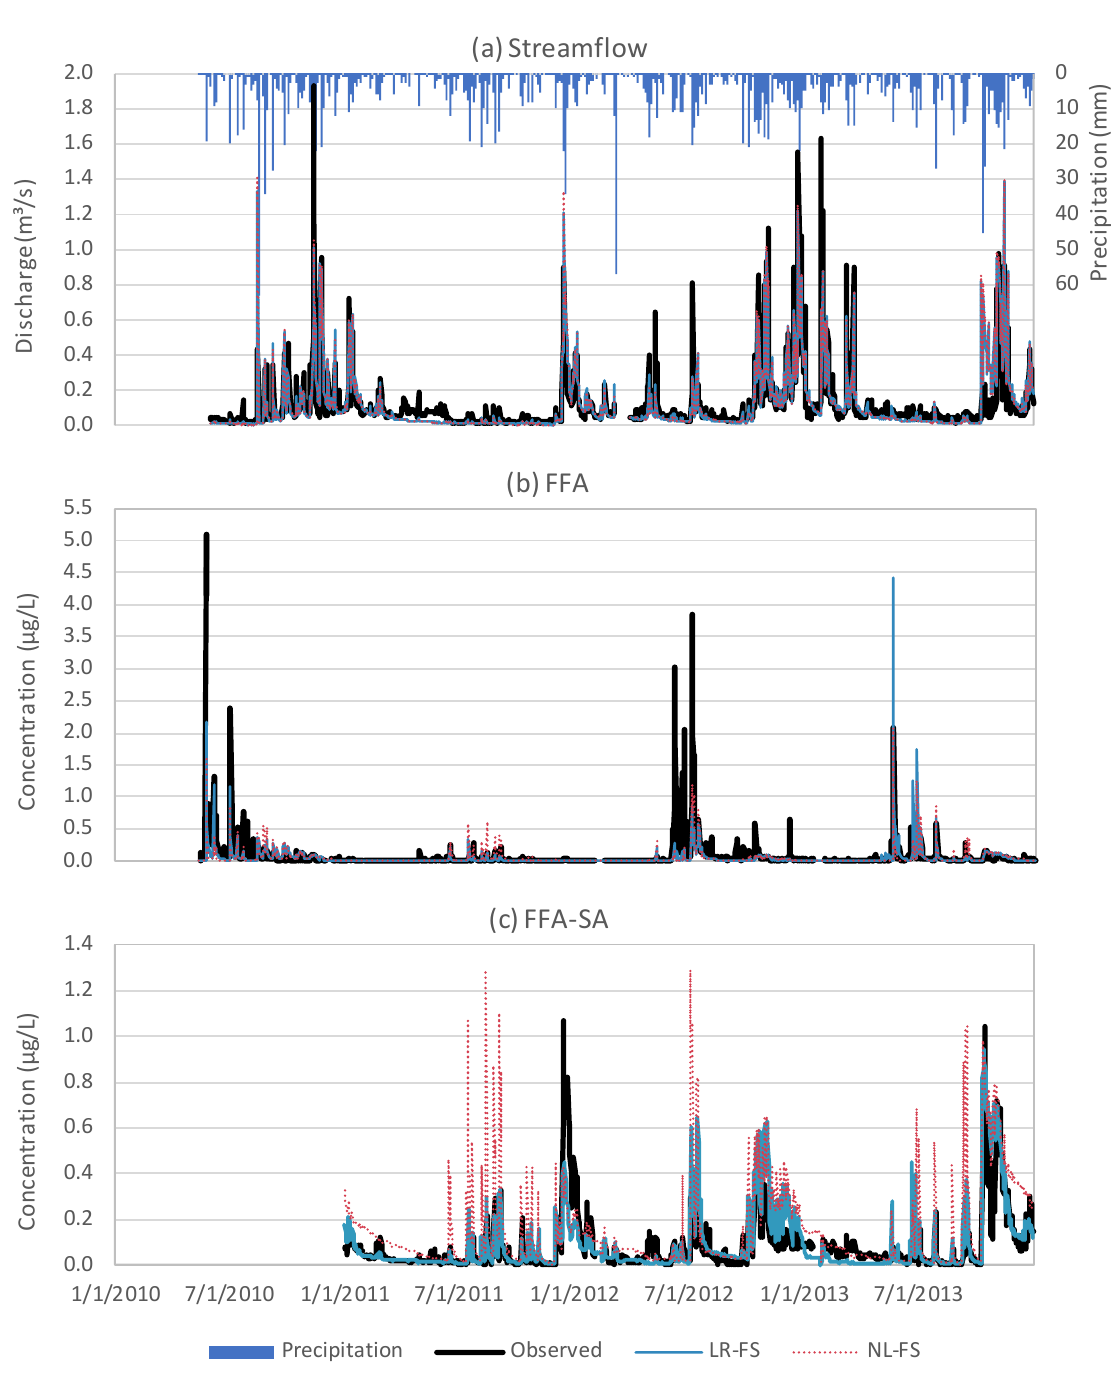
Figure 3. Observed and simulated LR-FS and NL-FS ( a ) streamflow, ( b ) FFA concentrations, and ( c ) FFA-SA concentrations.